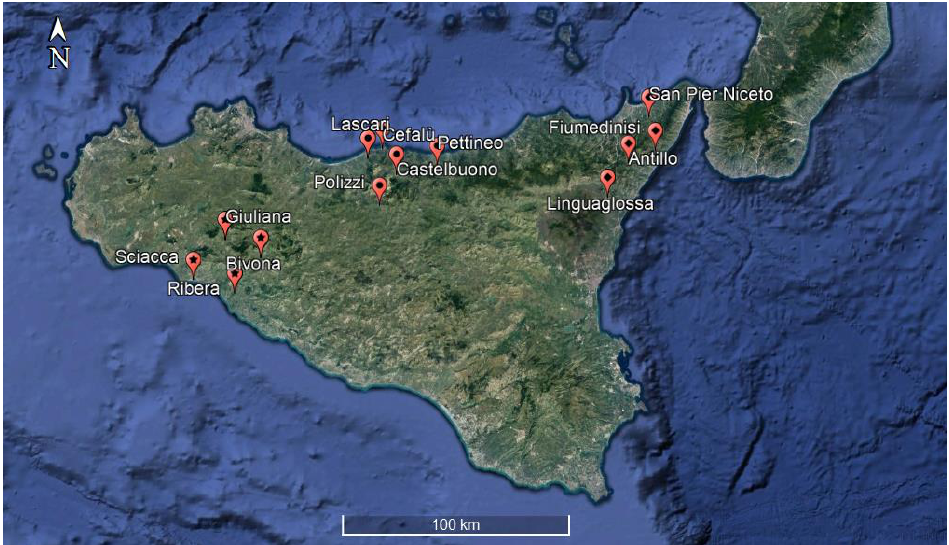
Figure 8. Map of weather stations used in this case study: 5 stations in the north of Sicily (Castelbuono, Lascari, Pettineo, Polizzi, and Cefalù), 4 in the northeast sector (Antillo, Fiumedinisi, Linguaglossa, and San Pier Niceto), and 4 in the southwest (Bivona, Giuliana, Ribera, and Sciacca).